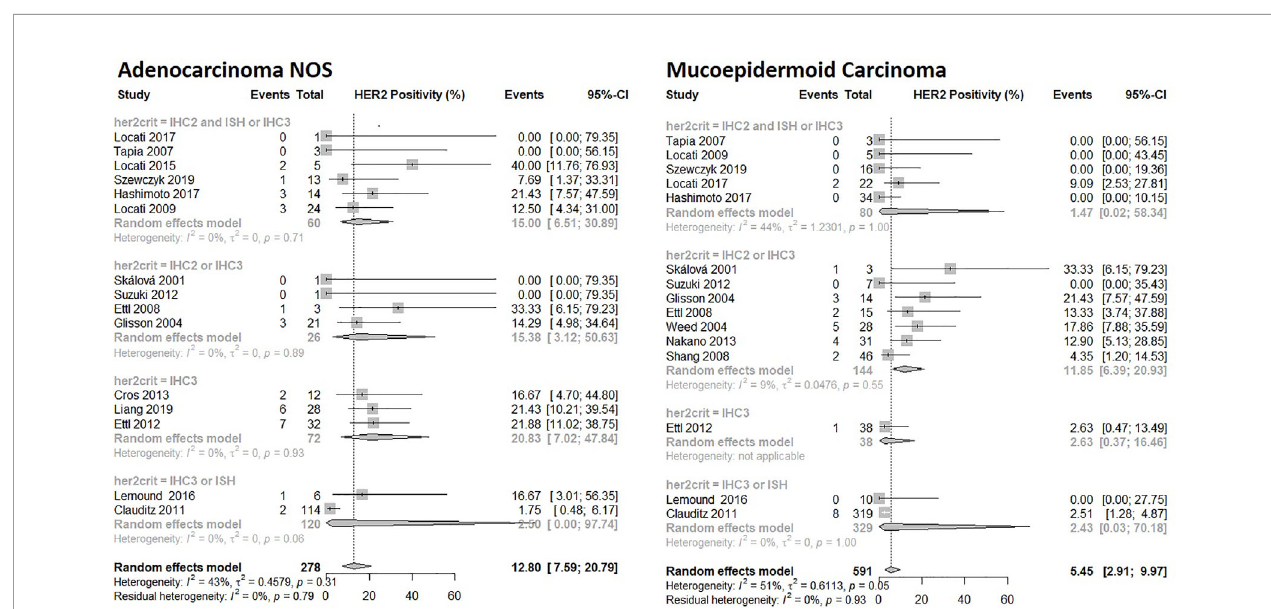
FIGURE 4 | Forrest plot of HER2 Prevalence among SGC subtypes: Salivary Duct Carcinoma and Carcinoma ex pleomorphic adenoma.